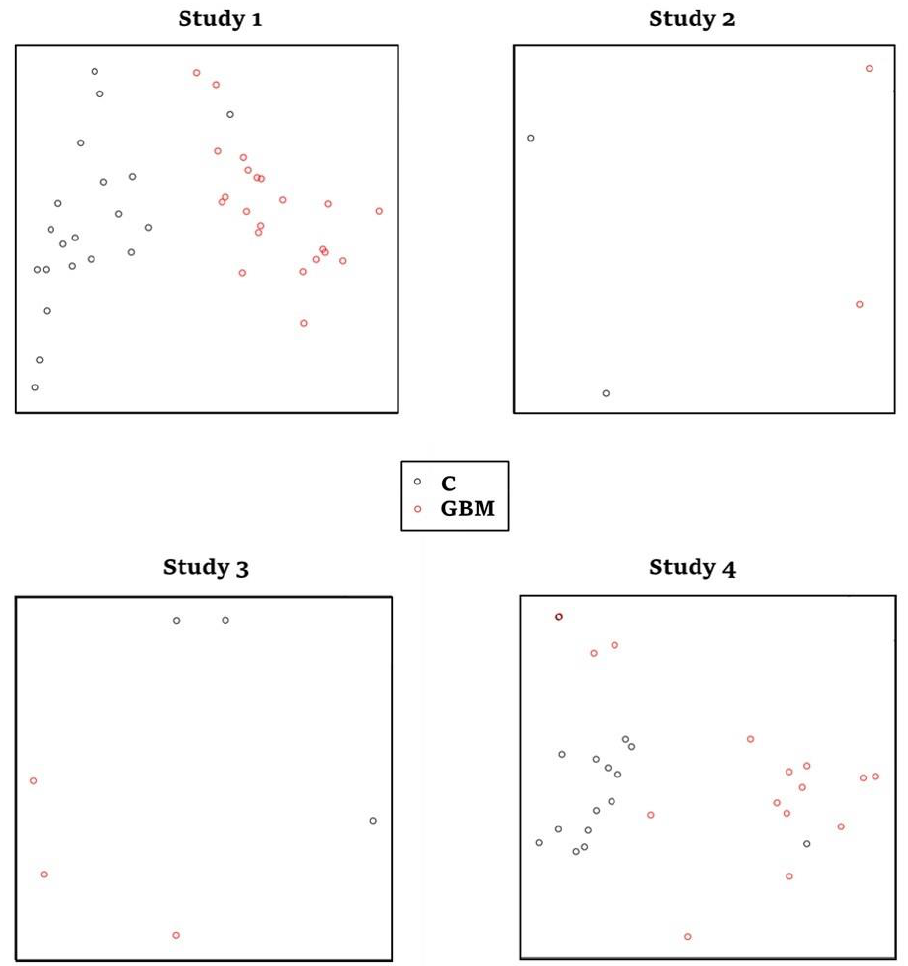
Figure 2. Output from the MetaPCA analytical module of the MetaOmics package showing principal component analyses (PCA) plots for the four selected studies (C: normal tissue controls, GBM: glioblastoma).